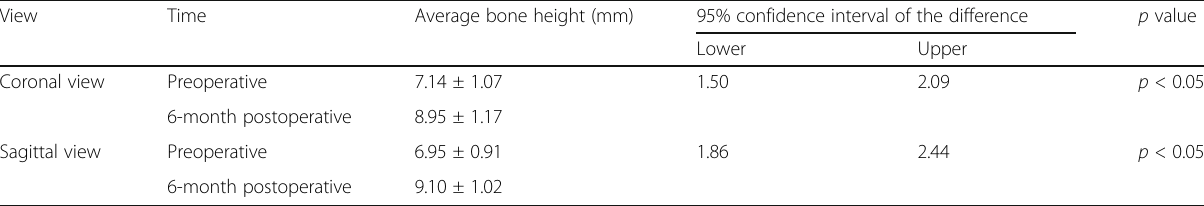
Table 1 Bone levels on CBCT images at preoperative and 6 months postoperative